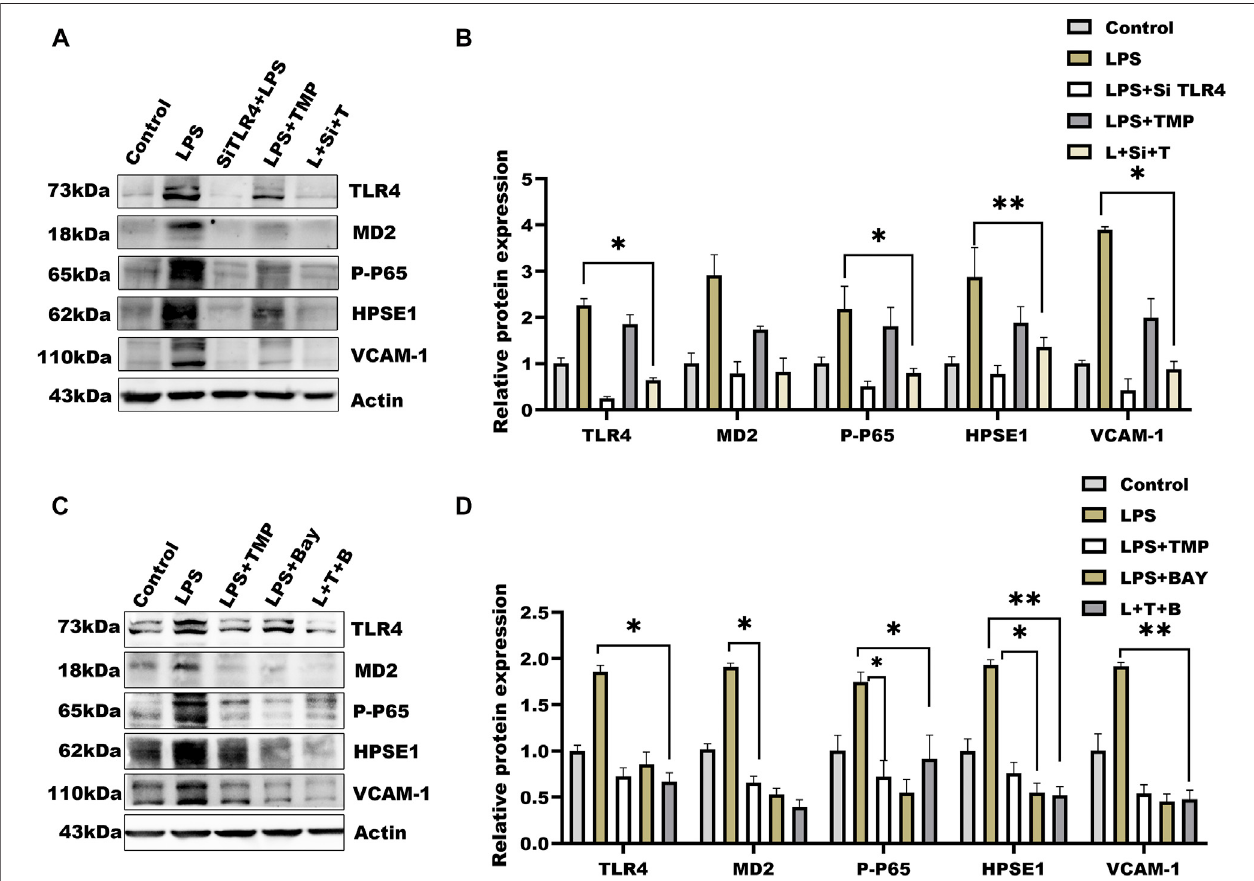
FIGURE 5 | Effect of TMP combined with siRNA TLR4 or NF- κ B inhibitor on expression of glycocalyx degradation associated proteins (A) Western blot analysis of short interference TLR4 after the HUVEC signal axis of the protein (B) Quantitative analysis of protein bands was performed by ImageJ software (C) Western blot was used to analyze the proteins on the signal axis of HUVEC after treatment with NF- κ B inhibitor BAY11-7082 (20 μ M) (D) Quantitative analysis of protein bands was performed by ImageJ software. * p < 0.05. ** p < 0.005; *** p < 0.001.